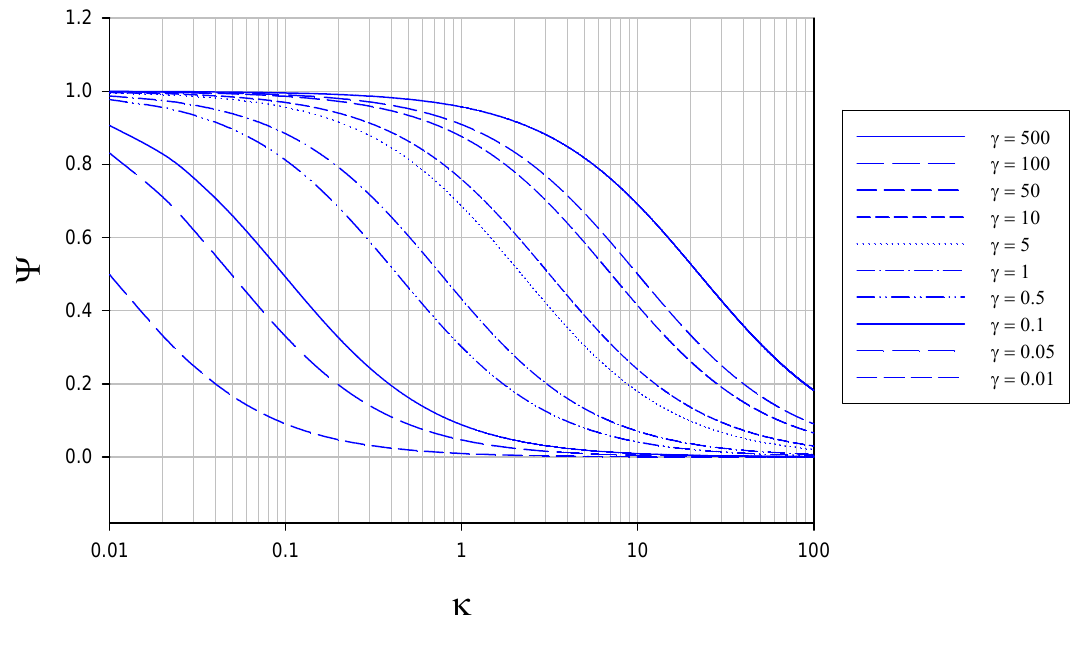
Figure 7. Variation of normalized flux Ψ with reaction/diffusion parameter κ for various fixed values of the parameter γ . The curves were calculated using eqn.26 in the